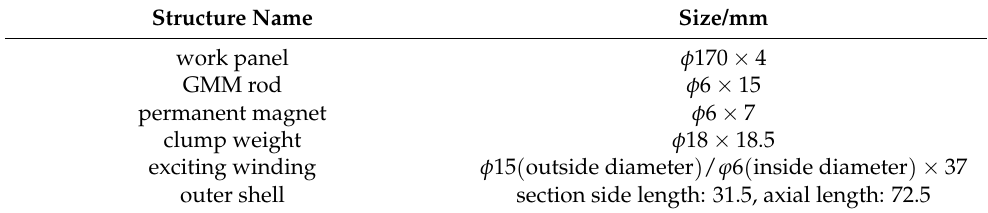
Table 1. Structural dimension